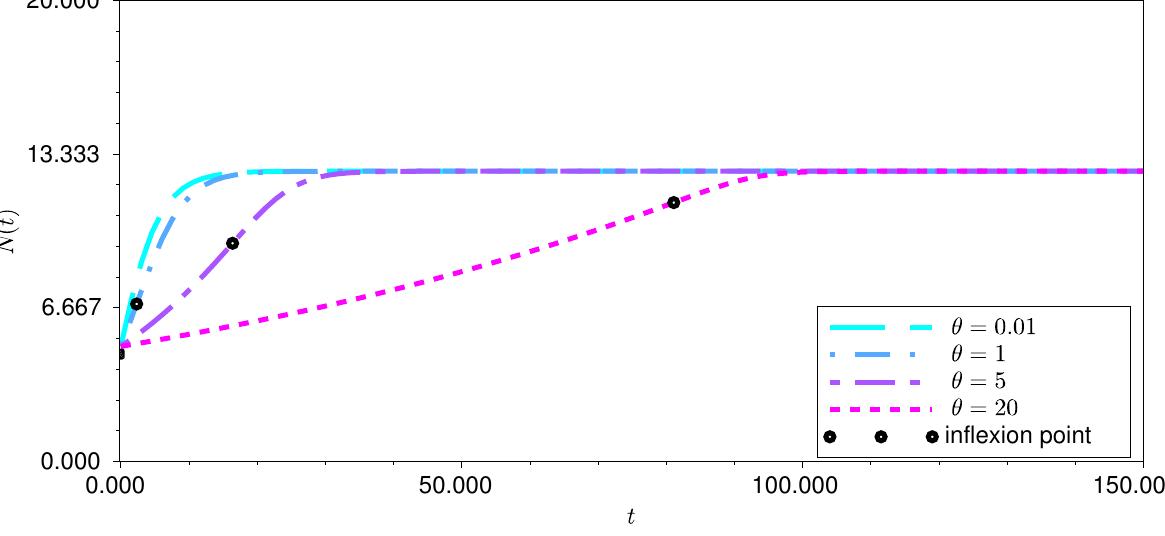
Figure 1. Profiles of N ( t ) in (13) for θ = 0.01,1,5,20 (with a = 0.2, b = 0.1, N 0 = 5 and K 0 = 20) and inflexion points calculated from (14) and